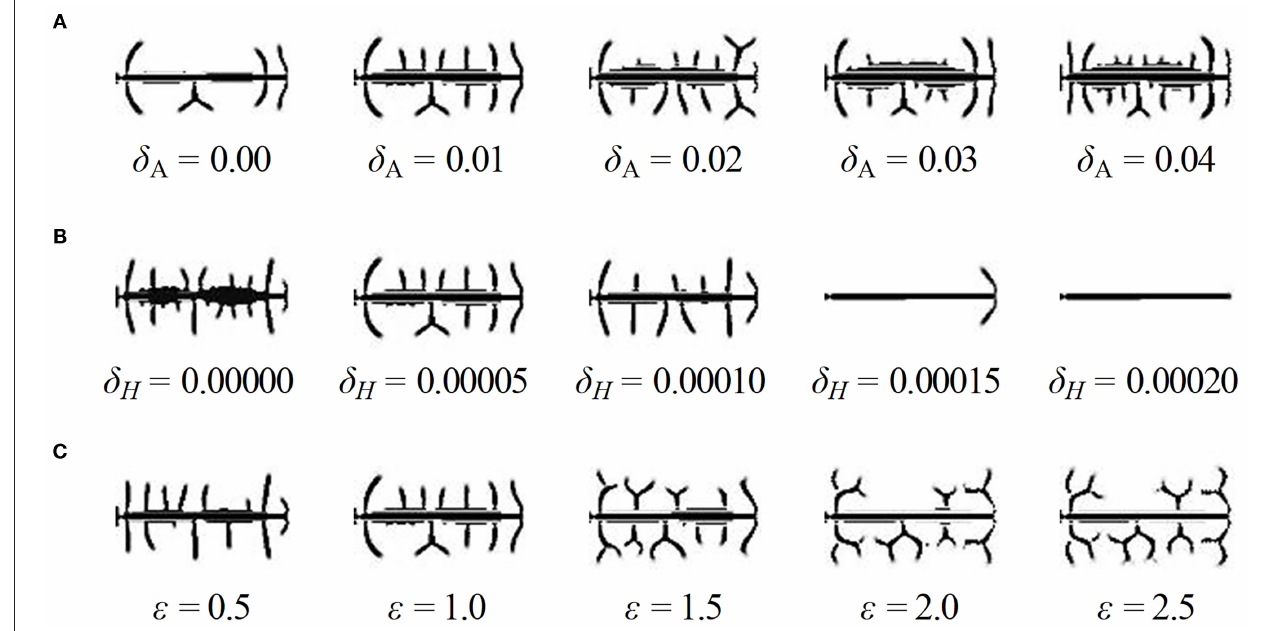
FIGURE 5 | Influence of parameters on the density of dendritic spines. (A) The results of dendrite simulation under the conditions of δ A = 0, 0.01, 0.02, 0.03, and 0.04, δ H = 0.00005, ε = 1. With the addition of an exogenous activator, the number of dendritic spines increases dramatically. (B) The results of dendrite simulation under the conditions of δ A = 0.01, δ H = 0, 0.00005, 0.0001, 0.00015, and 0.0002, ε = 1. With the addition of an exogenous inhibitor, the number of dendritic spines decreases dramatically. (C) The results of dendrite simulation under the conditions of δ A = 0.01, δ H = 0.00005, ε = 0.5, 1, 1.5, 2, and 2.5. With increased neuron activity, the shape varies from non-branched-dominant to branched-dominant. Branched-type spines take up more space; thus, the growth of surrounding spines is inhibited. In addition, the parameter ε has no effect on the density; for example, the densities are the same under the conditions of ε = 2 and ε = 2.5. In (A–C) , fixed parameters in Equation (2): c = 0.002, µ = 0.16, υ = 0.04, ρ A = 0.02, ρ H = 0.00005, c 0 = 0.05, γ = 0.02, D A = 0.02, D H = 0.26, D S = 0.06, d = 0.0035, e = 0.1, and f =